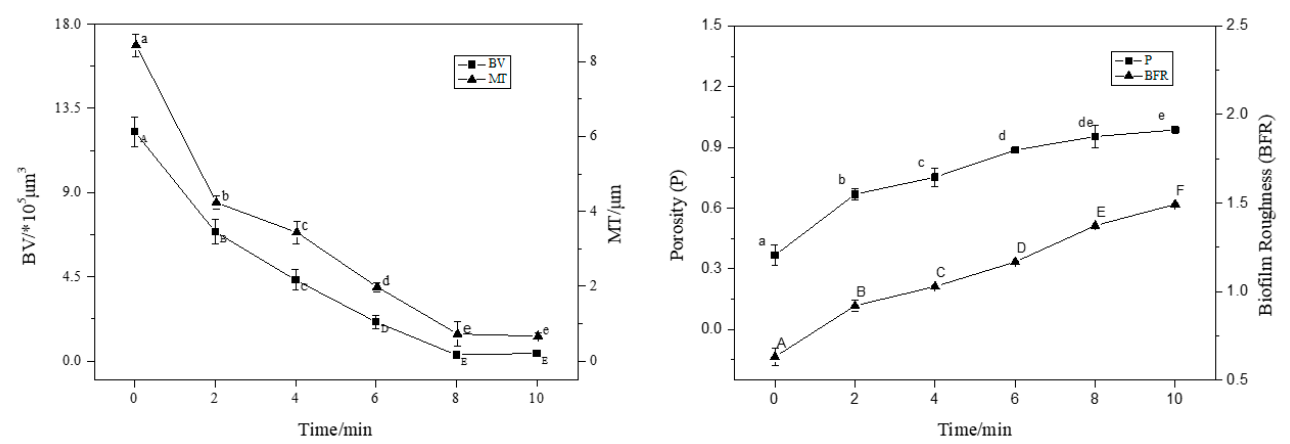
Figure 3. The CLSM images analysed by ISA-2 software to determine the biovolume (BV), mean thickness (MT), porosity (P) and biofilm roughness (BFR) of the biofilm. Data were expressed by mean measurements ± standard deviation (SD), and all treatments and determinations were performed in triplicate. The different letters indicate significant differences ( p < 0.05).